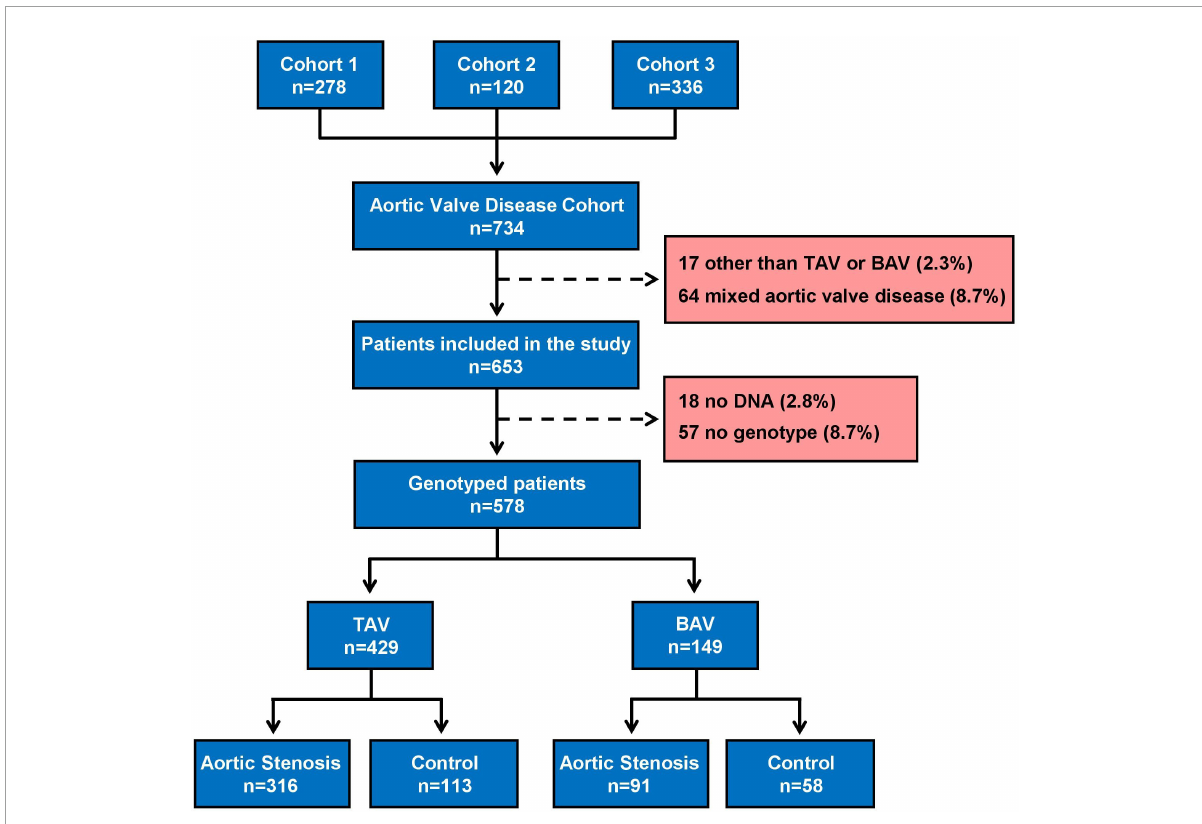
FIGURE1 Flowchart of patient selection. BAV, Bicuspid aortic valve; TAV, Tricuspid aortic valve; Control, normally functioning aortic valve plus aortic